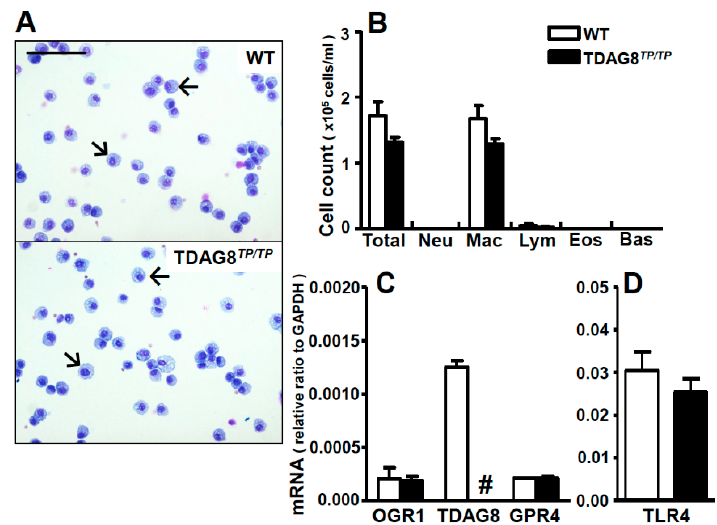
Figure 2. Macrophages are major cell types expressing TDAG8 in BAL fluids. ( A ) Representative cell images of BAL fluids of WT and TDAG8 TP/TP mouse. Arrows represent macrophages. Scale bar is 100 µm; ( B ) Differential cell counts in BAL fluids. Total, total white blood cells; Neu, neutrophils; Mac, macrophages; Lym, lymphocytes; Eos, eosinophils; and Bas, basophils. Data are mean ± SEM of n = 6 for each group; ( C , D ) The mRNA expression profile of proton-sensing GPCRs and TLR4 in BAL fluid cells. # The expression of TDAG8 was undetectable. Eight to 10 mice were used in each set and data are mean ± SEM of three separate experiments.